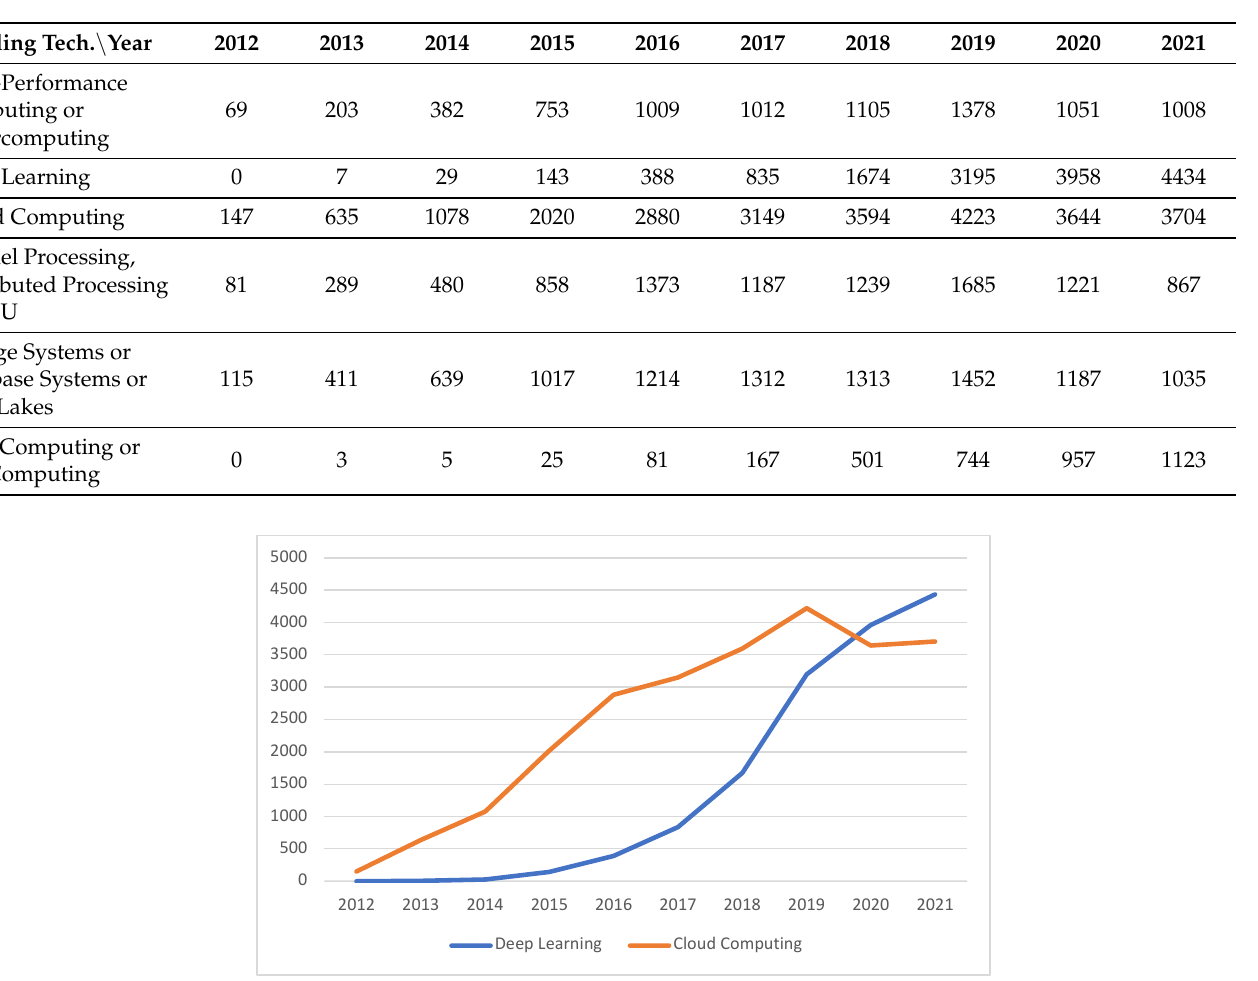
Figure 4. The number of research publications per year for the Big Data-enabling technologies deep learning and cloud computing.